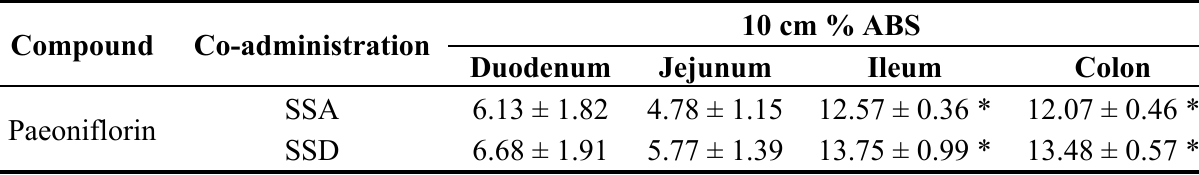
Table 3. 10% ABS of paeoniflorin co-administration with SSA and SSD in different intestinal segments ( x ± s, n =